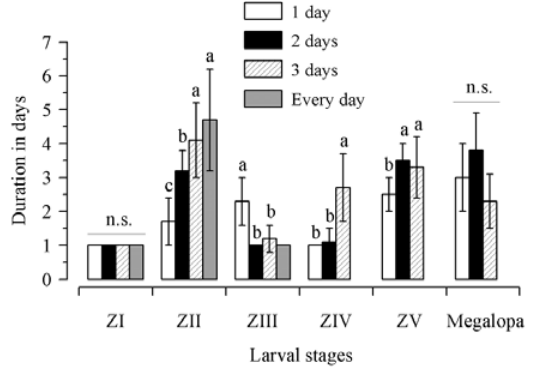
Fig. 4 – Zoeal and megalopal stage duration (in days, average ± stan- dard deviation) of Callichirus major submitted to an initial period of starvation. Larvae were starved for 1 day only (Treatment 1); Lar- vae were starved for 2 days (Treatment 2); Larvae were starved for 3 days (Treatment 3); Larvae were submitted to entire starvation (Con- trol treatment). n.s. = non significant differences among